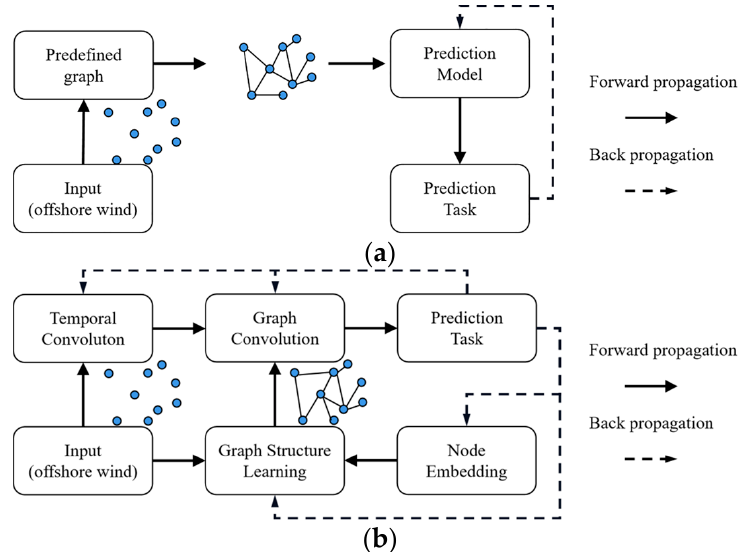
Figure 1. The workflow of the framework. ( a ) The workflow of a predefined graph. ( b ) The workflow of adaptive graph learning. First, the graph structure is inferred based on input and trainable node embedding. Then, the input and learned graph are entered into the temporal and graph convolution to extract a feature. Finally, the parameters of the model are optimized according to the prediction task.